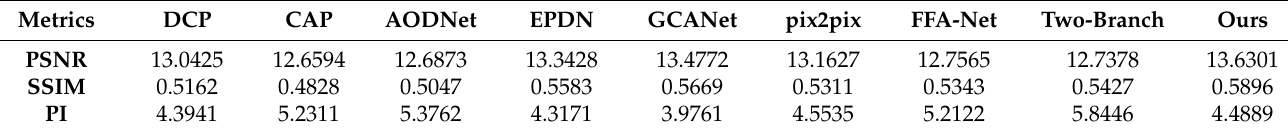
Table 3. Quantitative comparisons on the NTIRE dehazing challenge datasets with the network training on RESIDE datasets. Metrics